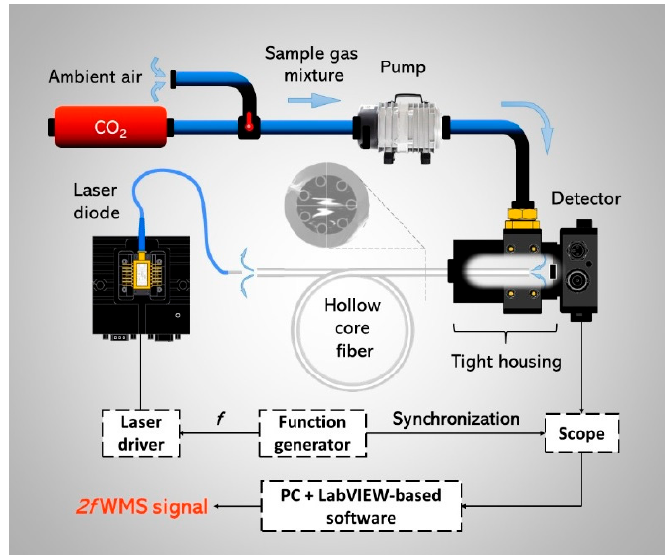
Figure 3. A schematic representation of the TDLAS/WMS gas sensor utilizing a 1.35 m long absorp- tion cell based on an ARHCF. Reprinted with permission from [21] © The Optical Society. tion cell based on an ARHCF. Reprinted with permission from [21] © The Optical